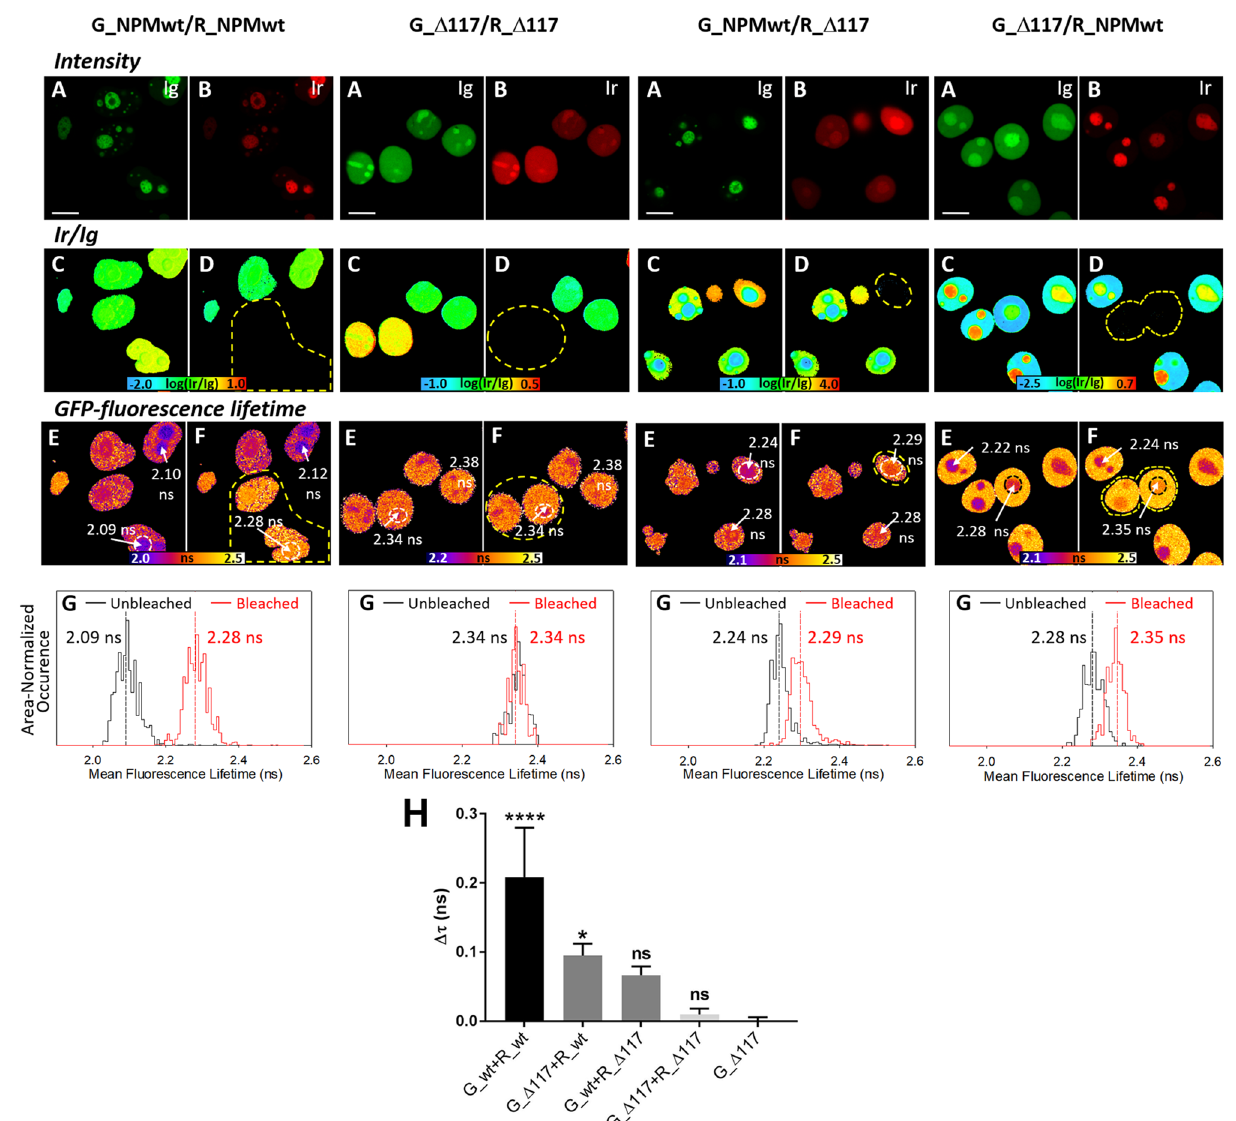
Figure 6. Effects of deletion in the N-terminal domain of NPM on its oligomerization in living 293T cells studied by FLIM-FRET. Interaction of eGFP- and mRFP1-labeled NPMwt causes shortening of the eGFP- fluorescence lifetime ( τ ) in co-transfected cells. After mRFP1-photobleaching, τ becomes prolonged, which confirms the G_NPMwt/R_NPMwt interaction. No lifetime change after mRFP1 photobleaching suggests absence of interaction between G_Δ117 and R_Δ117. ( A , B ) Initial localization of the green and red signal within the cells; ( C , D ) The intensity ratio of I red /I green before and after the photobleaching, respectively. ( E , F ) Fluorescence lifetime distribution of eGFP before and after the mRFP1-photobleaching; ( G ) lifetime histograms from the analyzed nucleolar area; ( H ) One-way ANOVA analysis of the eGFP fluorescence lifetime change after acceptor photobleaching. Changes are compared to the negative control G_Δ117. Error bars represent ± SD of at least 3 independent experiments (**** p < 0.0001; * p < indicates inability of the Δ117 mutants to interact with each other and to form multimers. This protein pair can therefore serve as a negative control for the multimer formation in the NSC348884 experiments. As seen from Fig. 6, in samples containing combination of the Δ117 deletion mutants with NPMwt, the GFP-lifetime slightly, but still visibly, increases upon the acceptor photobleaching. The change corresponds with the results of our electrophoretic experiments and suggests some amount of the mixed multimer to be present in the cell. The sta- tistical analysis from multiple experiments (n = 3–5) is presented in Fig. 6H, where cells transfected with G_Δ117 (the donor only transfection) served as a negative control. The figure clearly proves oligomerization of NPMwt. Oligomerization of Δ117 deletion mutants is clearly undetected and the presence of mixed NPMwt + Δ117 mul- timers is at the significance limit. Interestingly, the statistical evaluation also suggests the asymmetric character of interaction between NPMwt and Δ variants. These results are in a nice agreement with the immunoprecipitation.